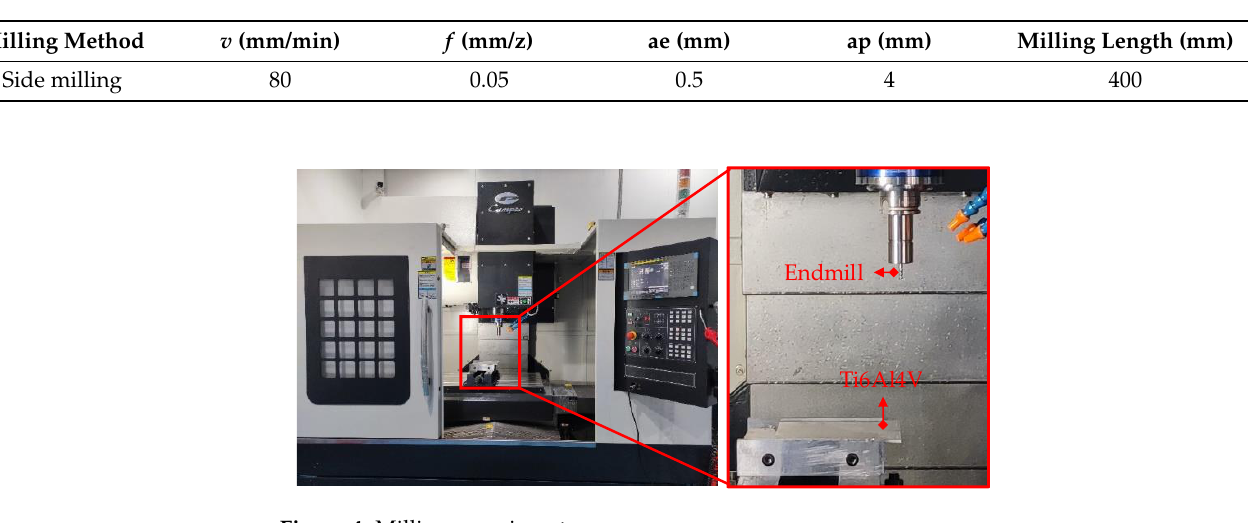
Table 5. Properties of the Ti6Al4V.